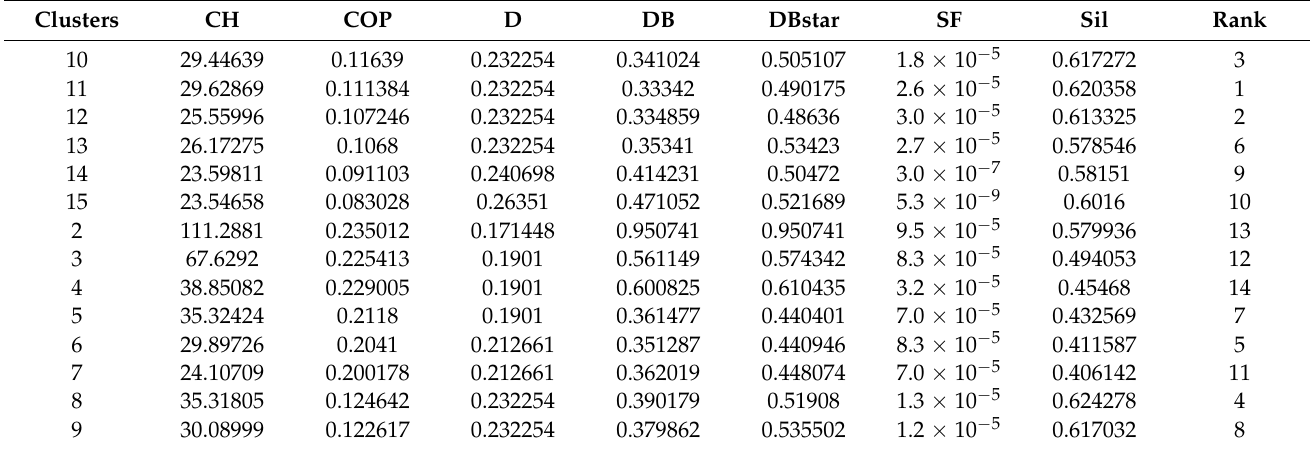
Table 6. CVI results for females aged over 60.